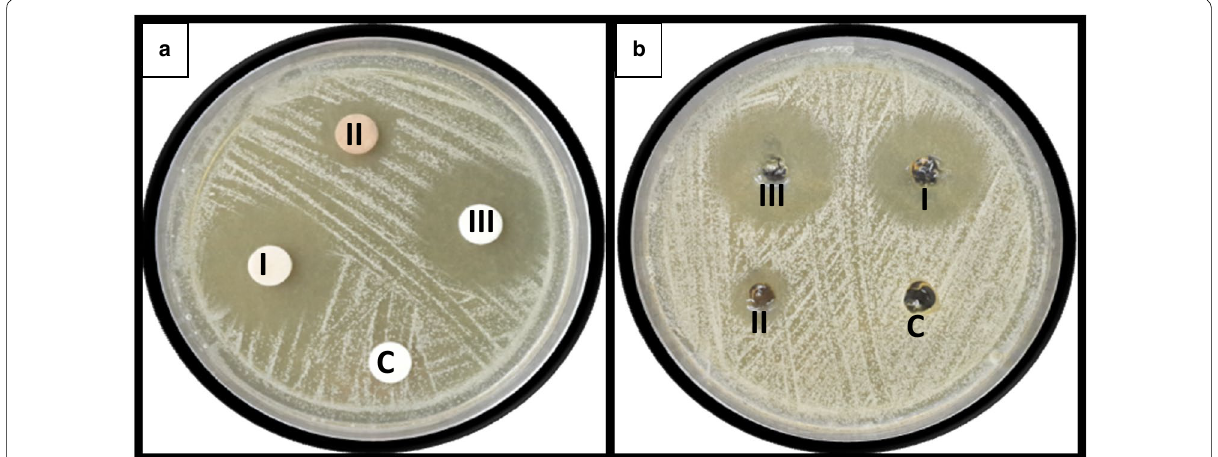
Fig. 3 Evaluation of the antifungal activity against M. furfur CBS 7019 by a disk diffusion and b agar well diffusion assay. I: KTZ; II: AgNP; III: KTZ AgNP; C: +